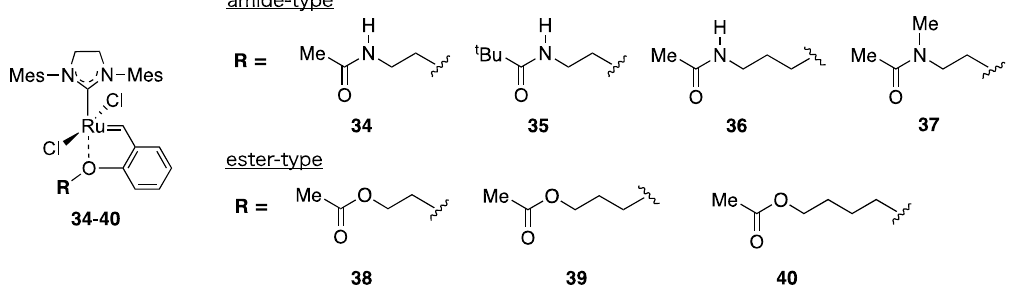
Figure 12. HG-II-type complexes equipped with an amide or ester moiety at the terminal of the phenolic moiety [65]. The stabilities of HG-II-type complexes 34 – 40 were evaluated by the ligand exchange reaction between HG-II complex 5 and ligand precursors 34 -L – 40 -L with a stoichiometry of 1:1 (Scheme 7).